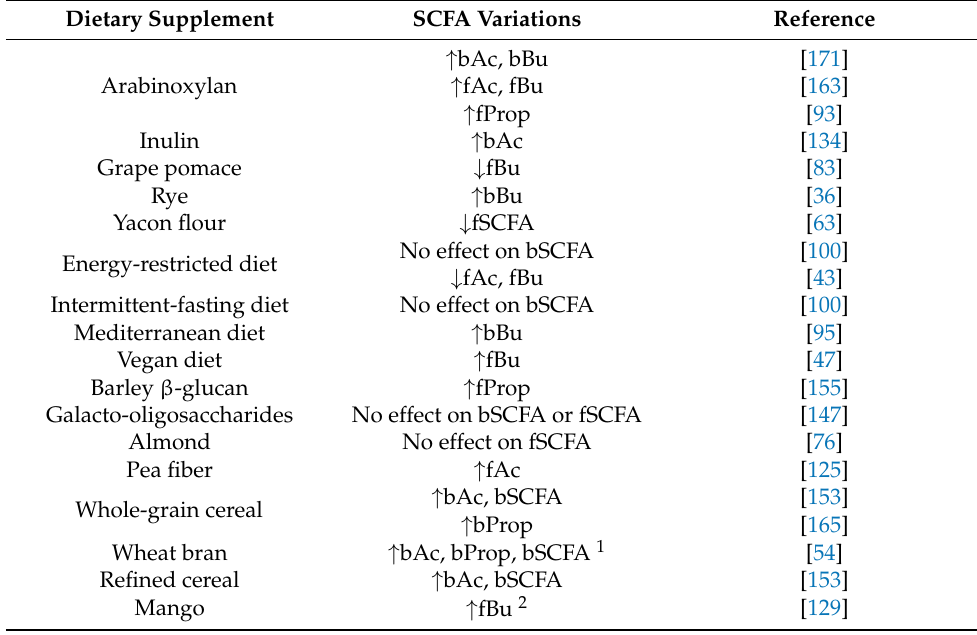
Table 4. Effects of dietary supplements and various diets on SCFA levels in